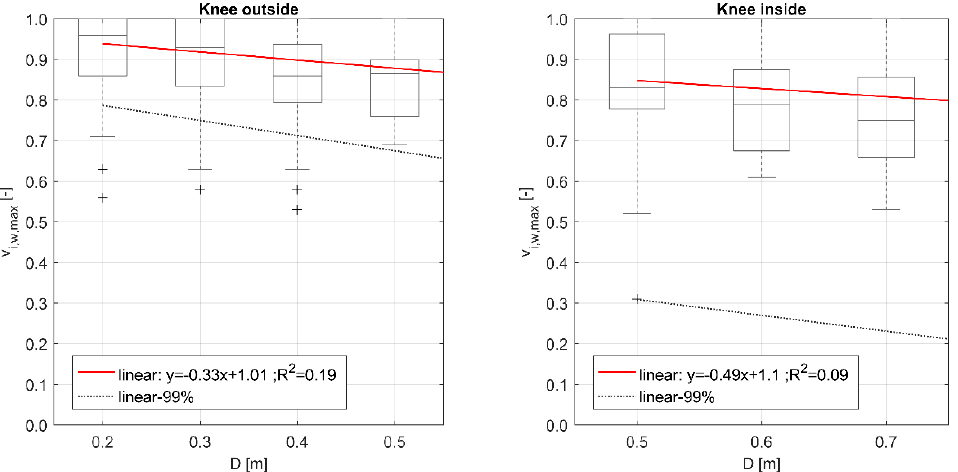
Figure 17. Effects of knee position (outside and inside the floodwater level) on the normalized speed